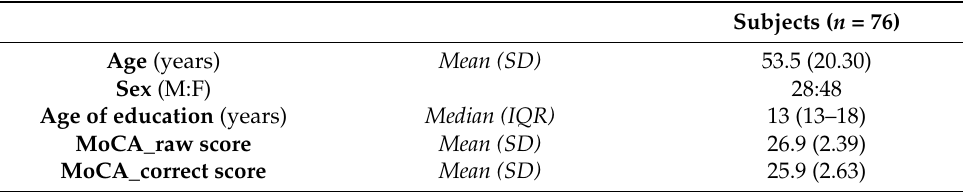
Table 2. Demographic and clinical characteristics of the whole sample.